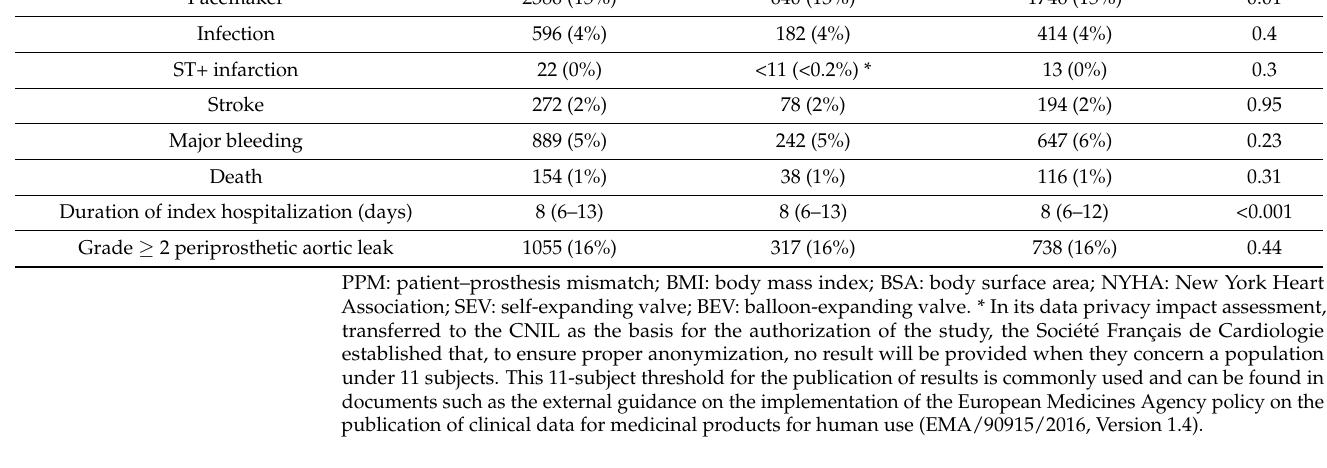
Table 2. Baseline and postimplantation characteristics (PVL